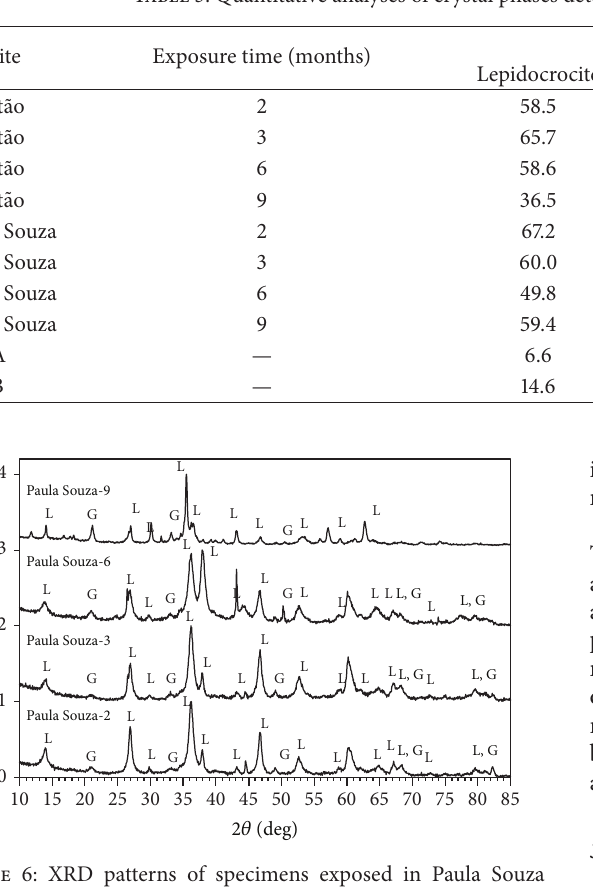
Table 3: Quantitative analyses of crystal phases determined by Rietveld refinement of XRD data.